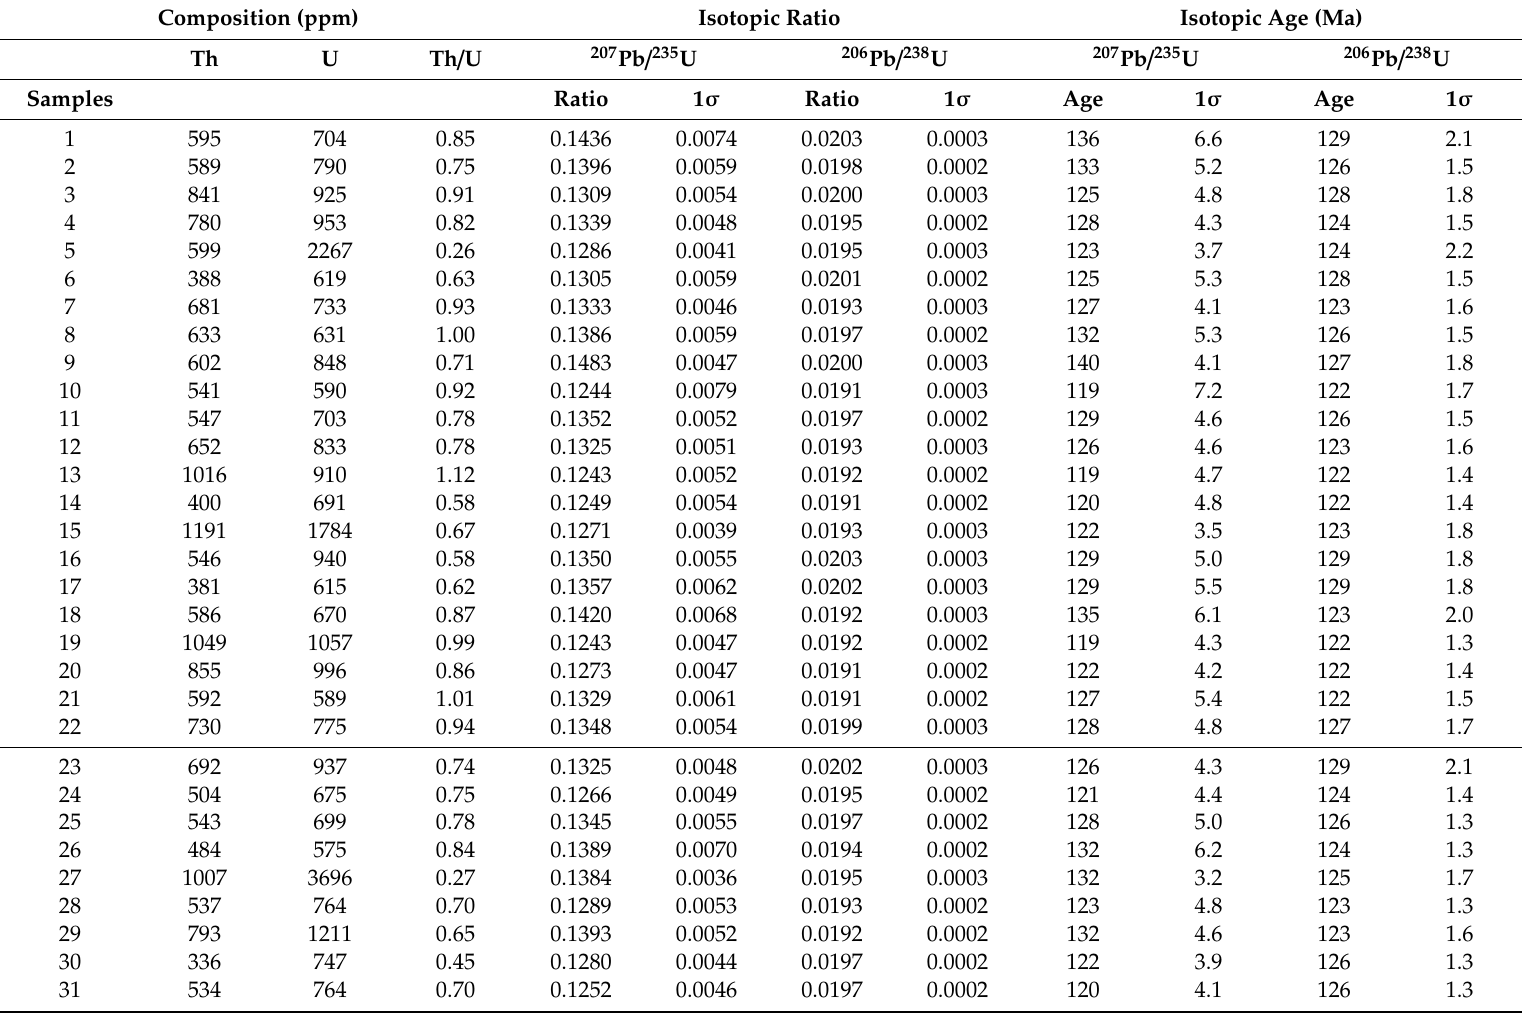
Table 1. Zircon U-Pb isotopic compositions and ages of the Xianglushan biotite granite ("PLE" represent the “Plesovice